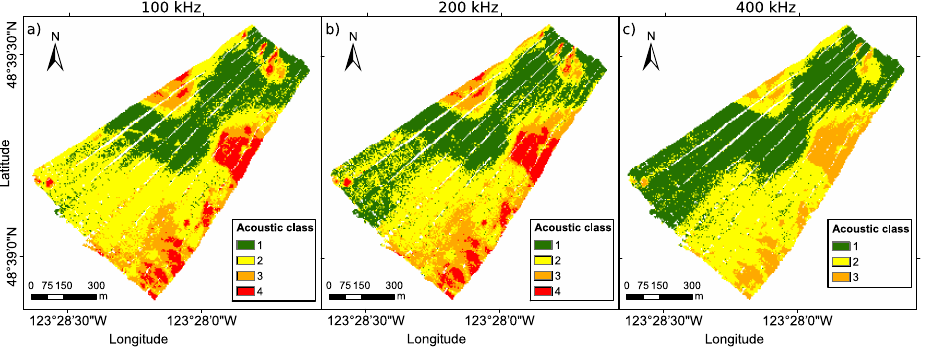
Figure 9. AC maps of the Patricia Bay at ( a ) 100, ( b ) 200, and ( c ) 400 kHz. The spatial resolution is 5m by 5m. White spots indicate no data caused by neglected backscatter data at